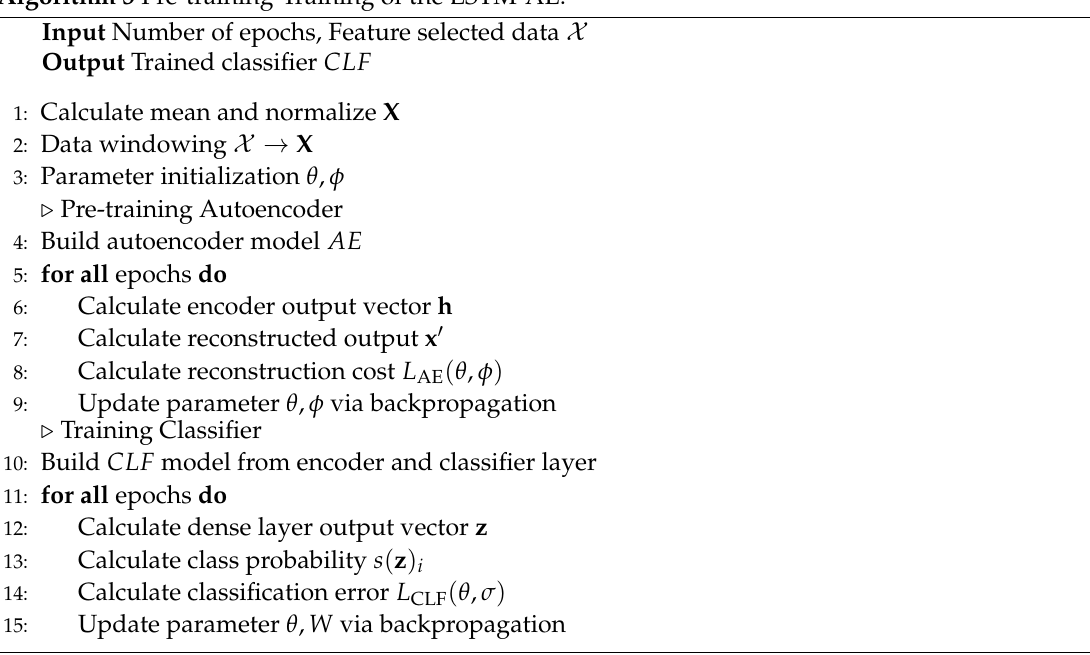
Figure 5. Schema of the proposed fault detection method. Algorithm 3 Pre-training-Training of the